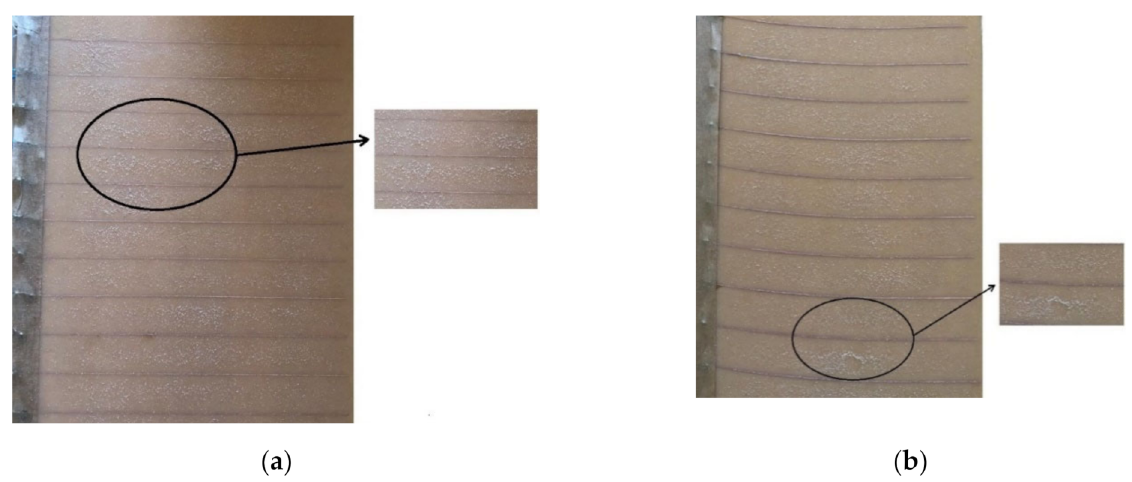
Figure 10. Dust distribution and accumulation as a result of single channel application to: ( a ) M1 model; ( b ) M2 model.